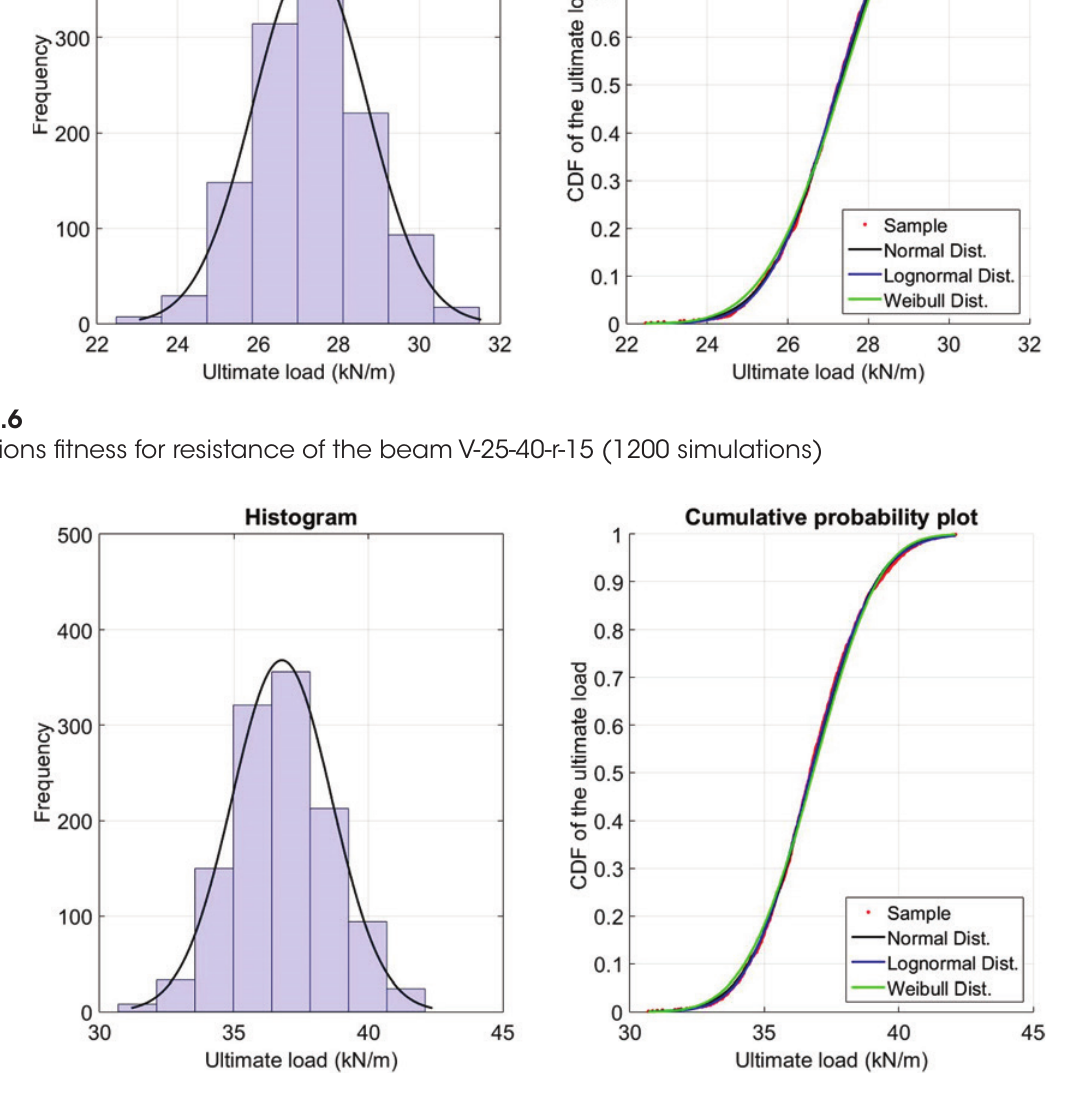
Figure 6.7 Distributions fitness for resistance of the beam V-25-40-r-20 (1200 simulations)